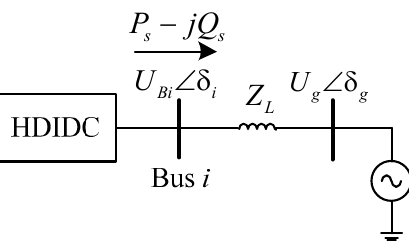
Figure 2. The equivalent network of the hybrid dual ‐ infeed HVDC (HDIDC) system under grid fault.